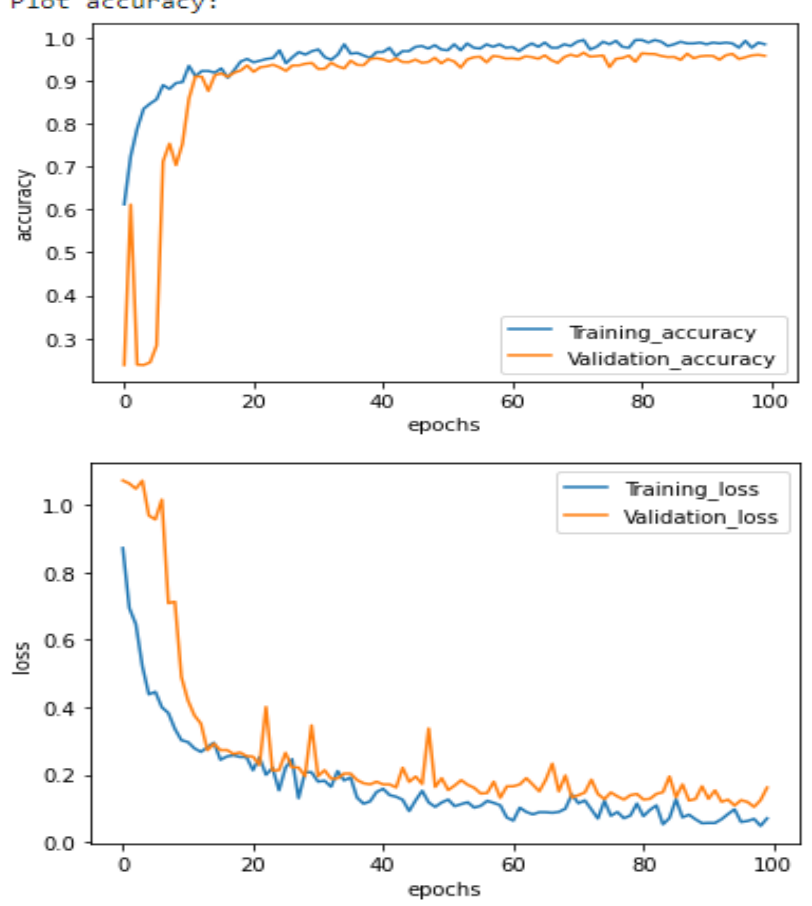
Figure 8. Accuracy and loss performance of the ResNet50 model. The confusion matrix for the ResNet50, MobileNet, and MobiRes-Net models used in